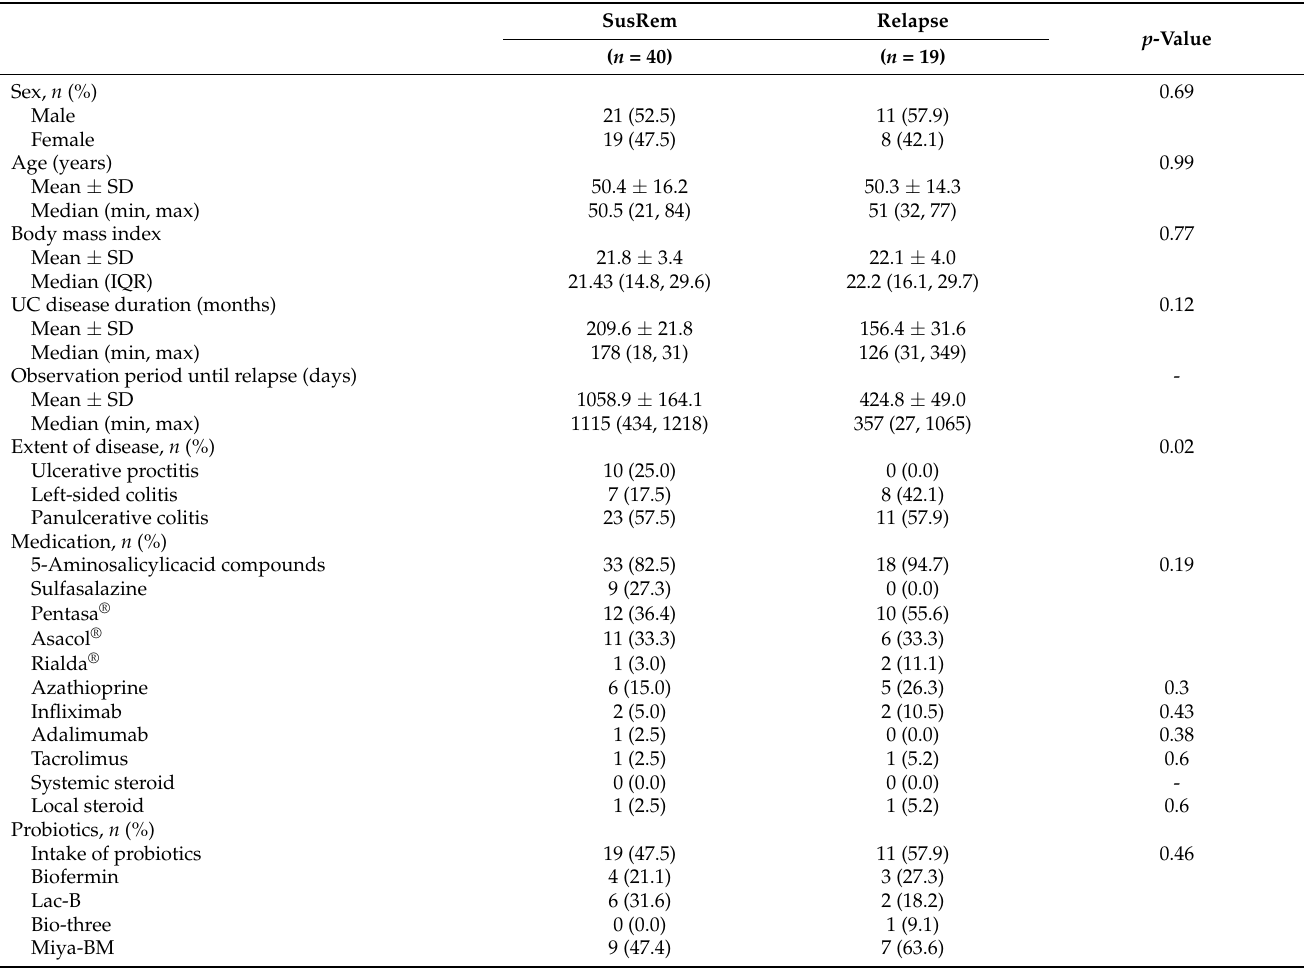
Table 3. Comparisons of the patients’ background between sustained remission and relapse